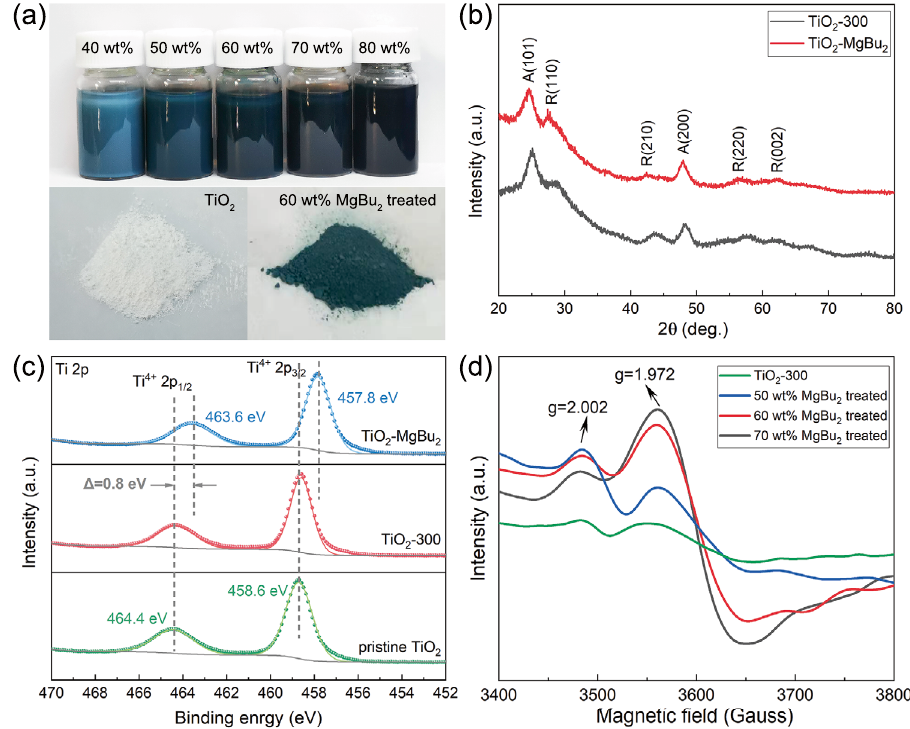
Fig. 4 a Optical photographs of TiO 2 NS suspension treated with different amounts of MgBu 2 . b XRD patterns of TiO 2 -300 and MgBu 2 -treated TiO 2 NS. c High-resolution XPS spectra of Ti 2 p . d EPR spectra of TiO 2 -300 and TiO 2 NS treated with different amounts of MgBu 2 ("40wt%/ 50wt%/ 60wt%/ 70wt%/ 80wt% " refers to the weight percentage of MgH 2 in the MgH 2 /TiO 2